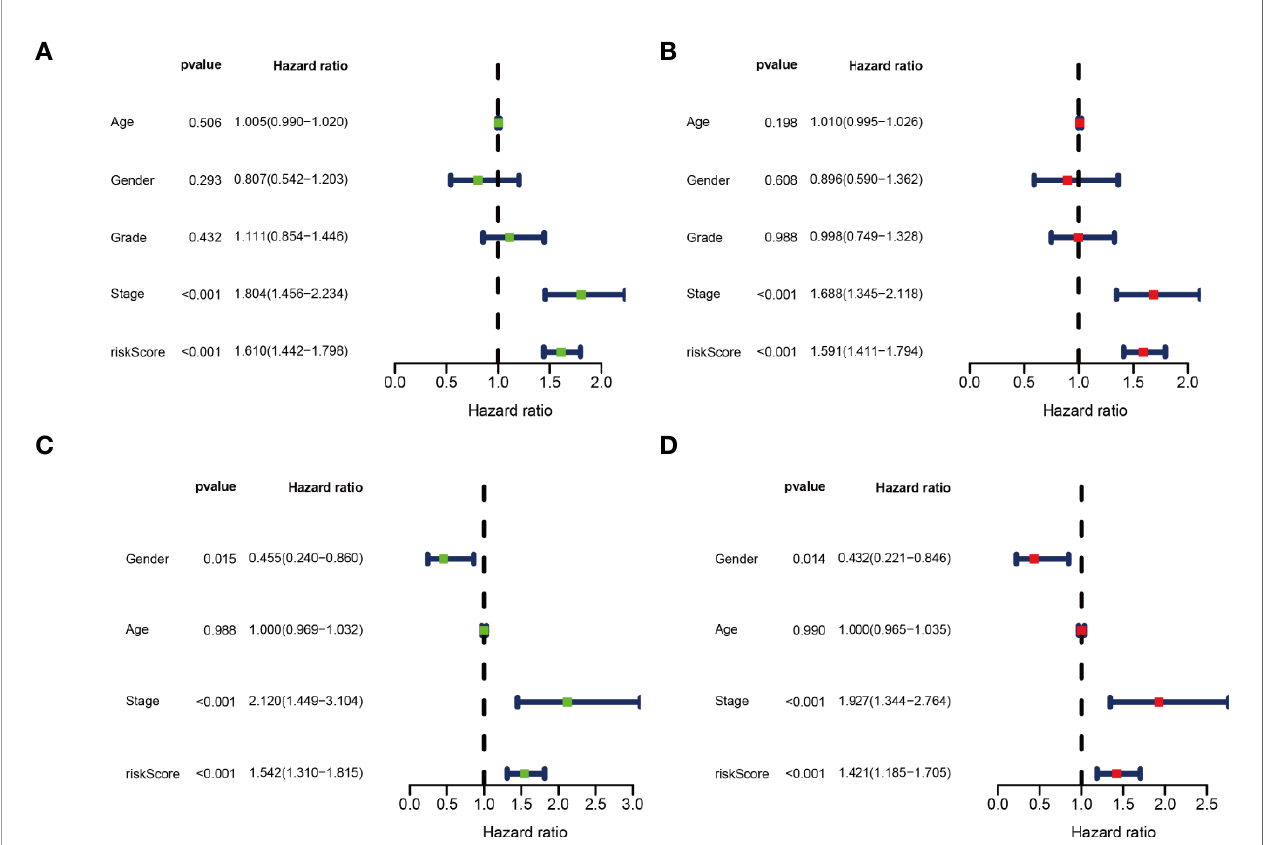
FIGURE 8 | Identi fi cation of independent prognostic indicators. (A) Forest plots for Univariate Cox regression analysis; (B) Multivariate Cox regression analysis in TCGA cohort; (C) Forest plots for Univariate Cox regression analysis; (D) Multivariate Cox regression analysis in ICGC cohort.